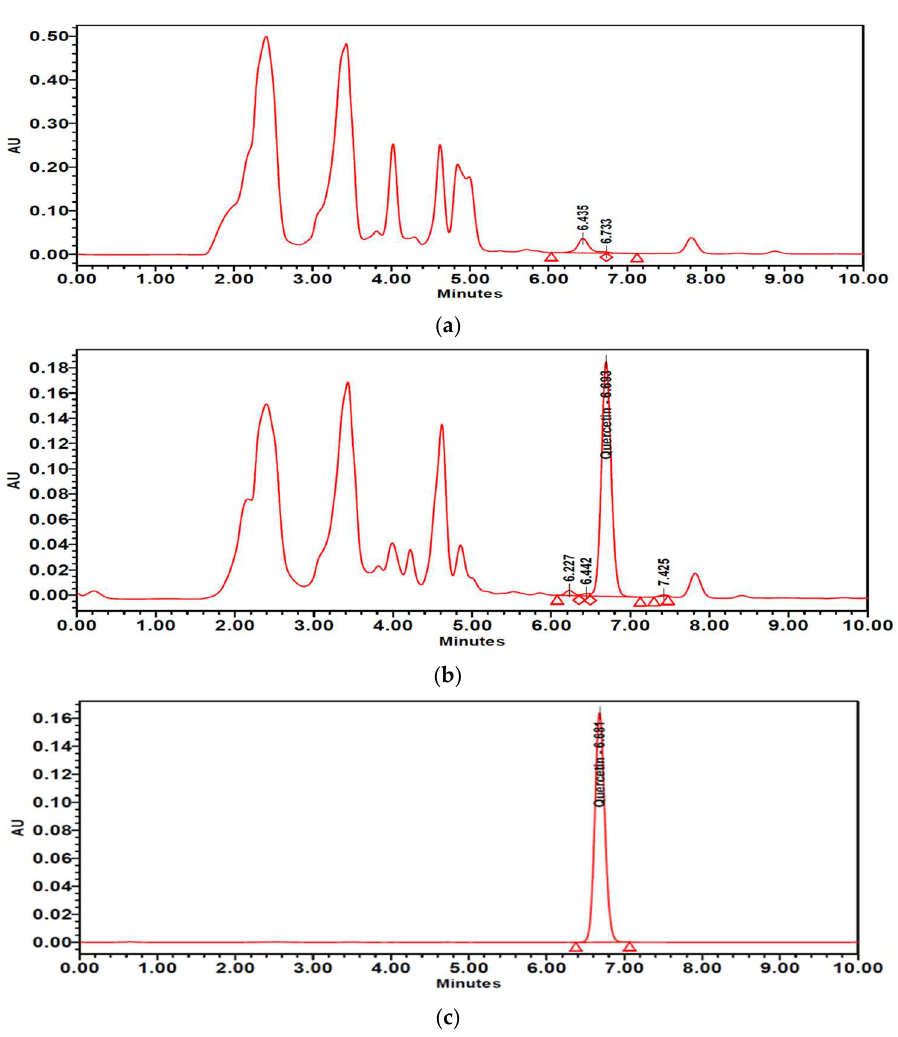
Figure 10. HPLC chromatograms of ( a ) PTFE and ( b ) PTFFE. ( c ) Peak of quercetin standard.